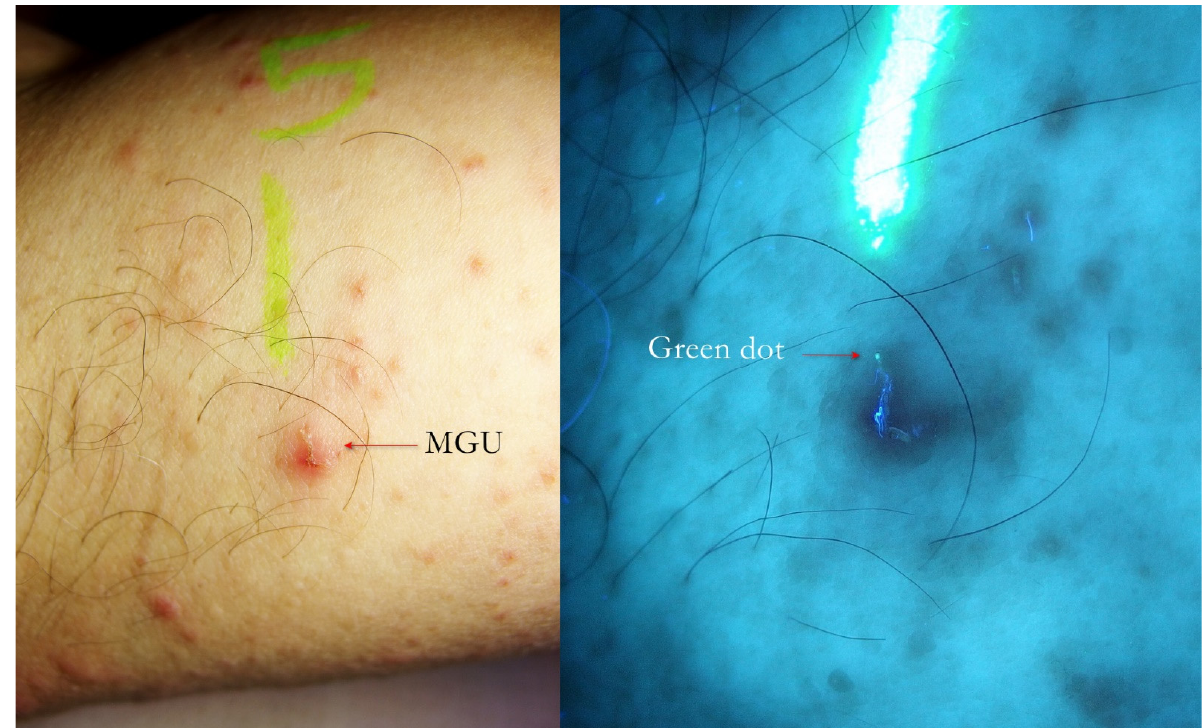
Figure 10. Flash light vs. UVA. A MGU was distinguishable to naked eye ( left ). UVA light drew attention to the green dot where Sarcoptes body was located. The gallery behind had a bluish hue partially caused by a fabric thread glued on MGU. A yellow highlighter was used.